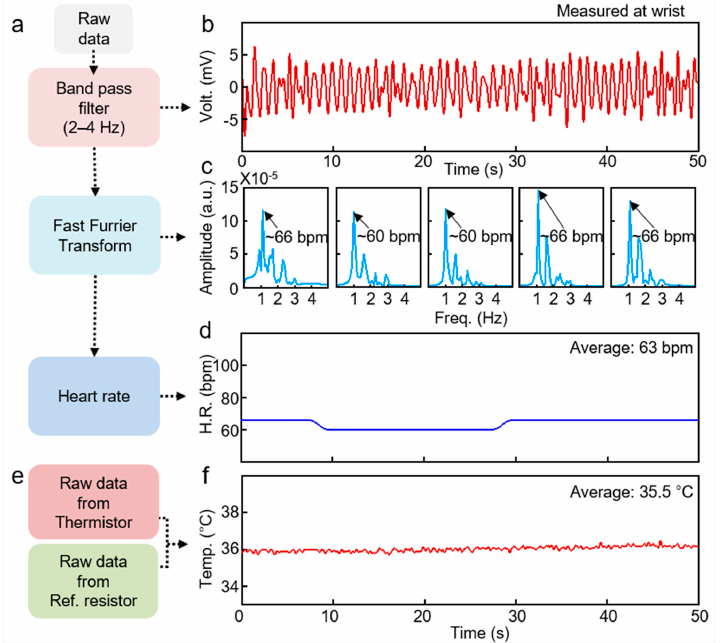
Figure 7. Flow chart and results for data processing. ( a ) Data processing flow for heart rate. ( b ) Pulsatile signal obtained by PD. ( c ) Fast Furrier Transform (FFT) result of the signal in ( b ) with 10-second window. ( d ) Heart rate calculated from ( c ). ( e ) Data processing flow for temperature. ( f ) Measured temperature.